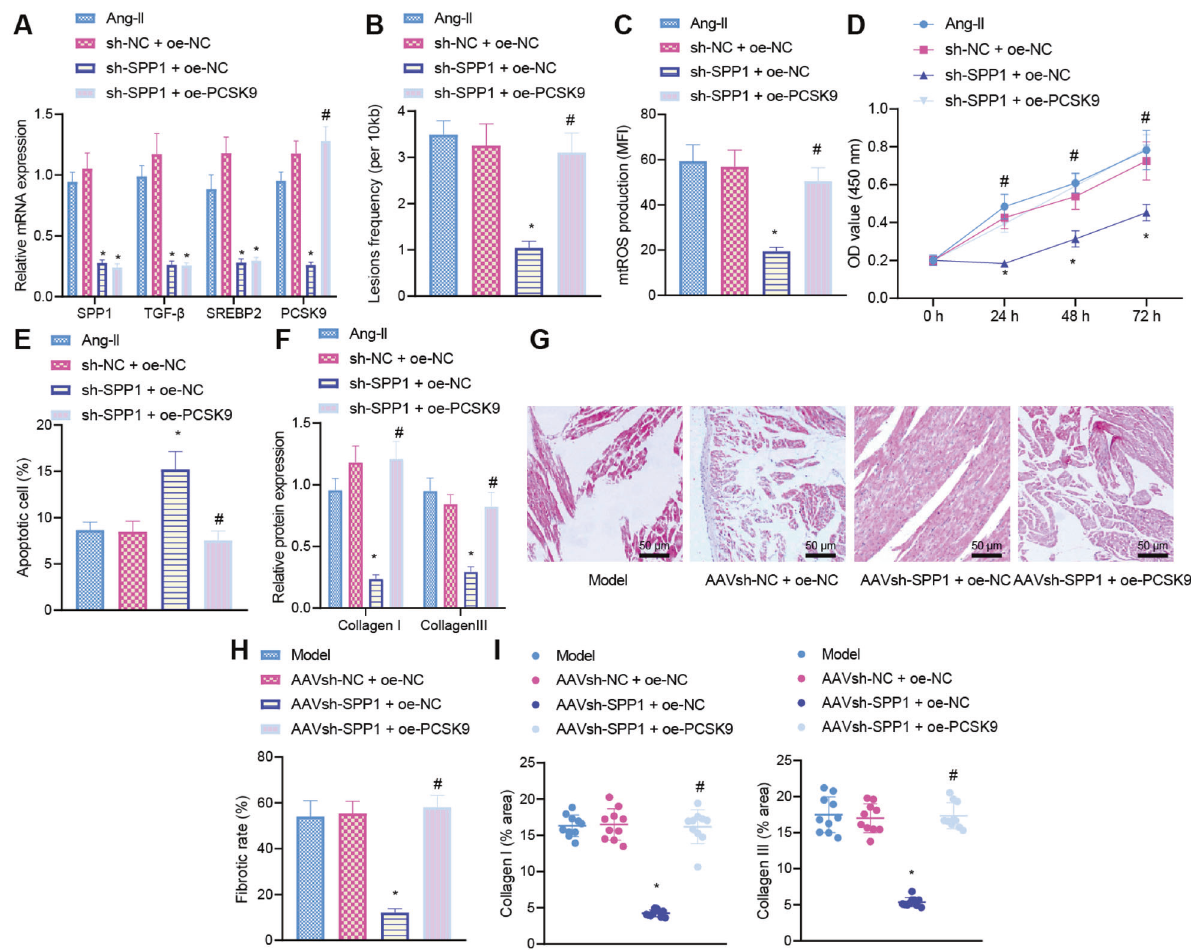
combined with oe-PCSK9. E TUNEL detection of apoptosis of HL-1 cells treated with sh-SPP1 or combined with oe-PCSK9. F Western blot analysis of collagen I and collagen III proteins in HL-1 cells treated with sh-SPP1 alone or in combination with oe-PCSK9. G HE staining of pathological changes of atrial tissues of Ang II-induced mice treated with sh-SPP1 or combined with oe-PCSK9. H Masson ’ s trichrome staining of atrial fi brosis degree in Ang II-induced mice treated with sh-SPP1 or combined with oe-PCSK9. I IHC analysis of collagen I and collagen III proteins in atrial tissues of Ang II-induced mice treated with sh-SPP1 or combined with oe-PCSK9. * p < 0.05, compared with Ang II-induced cells or mice treated with sh-NC + oe-NC. # p < 0.05, compared with the Ang II-induced cells or mice treated with sh-SPP1 + oe-NC. All experiments were repeated three times independently. n = 10 for mice in each